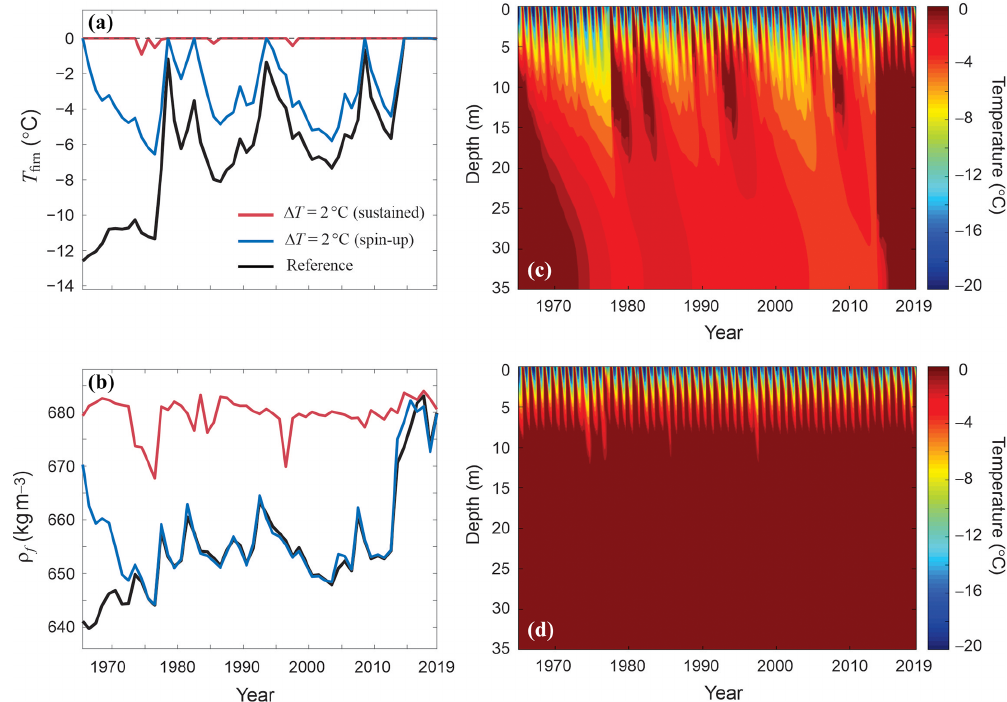
Figure 8. Modelled (a) 10m firn temperature and (b) average firn density for the reference model, for a 2 ◦ C temperature anomaly for the spin-up, and for a sustained temperature anomaly of + 2 ◦ C. (c, d) Firn temperature evolution for (c) the warm spin-up, followed by the reference climatology, and (d) sustained 2 ◦ C temperature